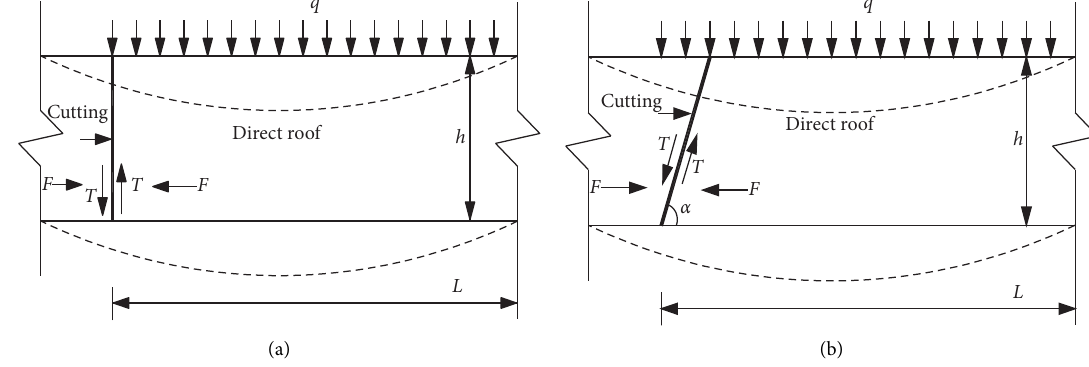
Figure 6: Mechanical model of angle roof of cutting seam in goaf. (a) Vertical seam cutting. (b) Inclined seam